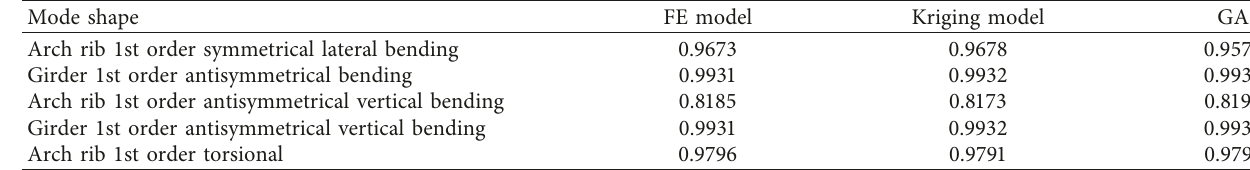
Table 5: The MAC values of each model updating method.